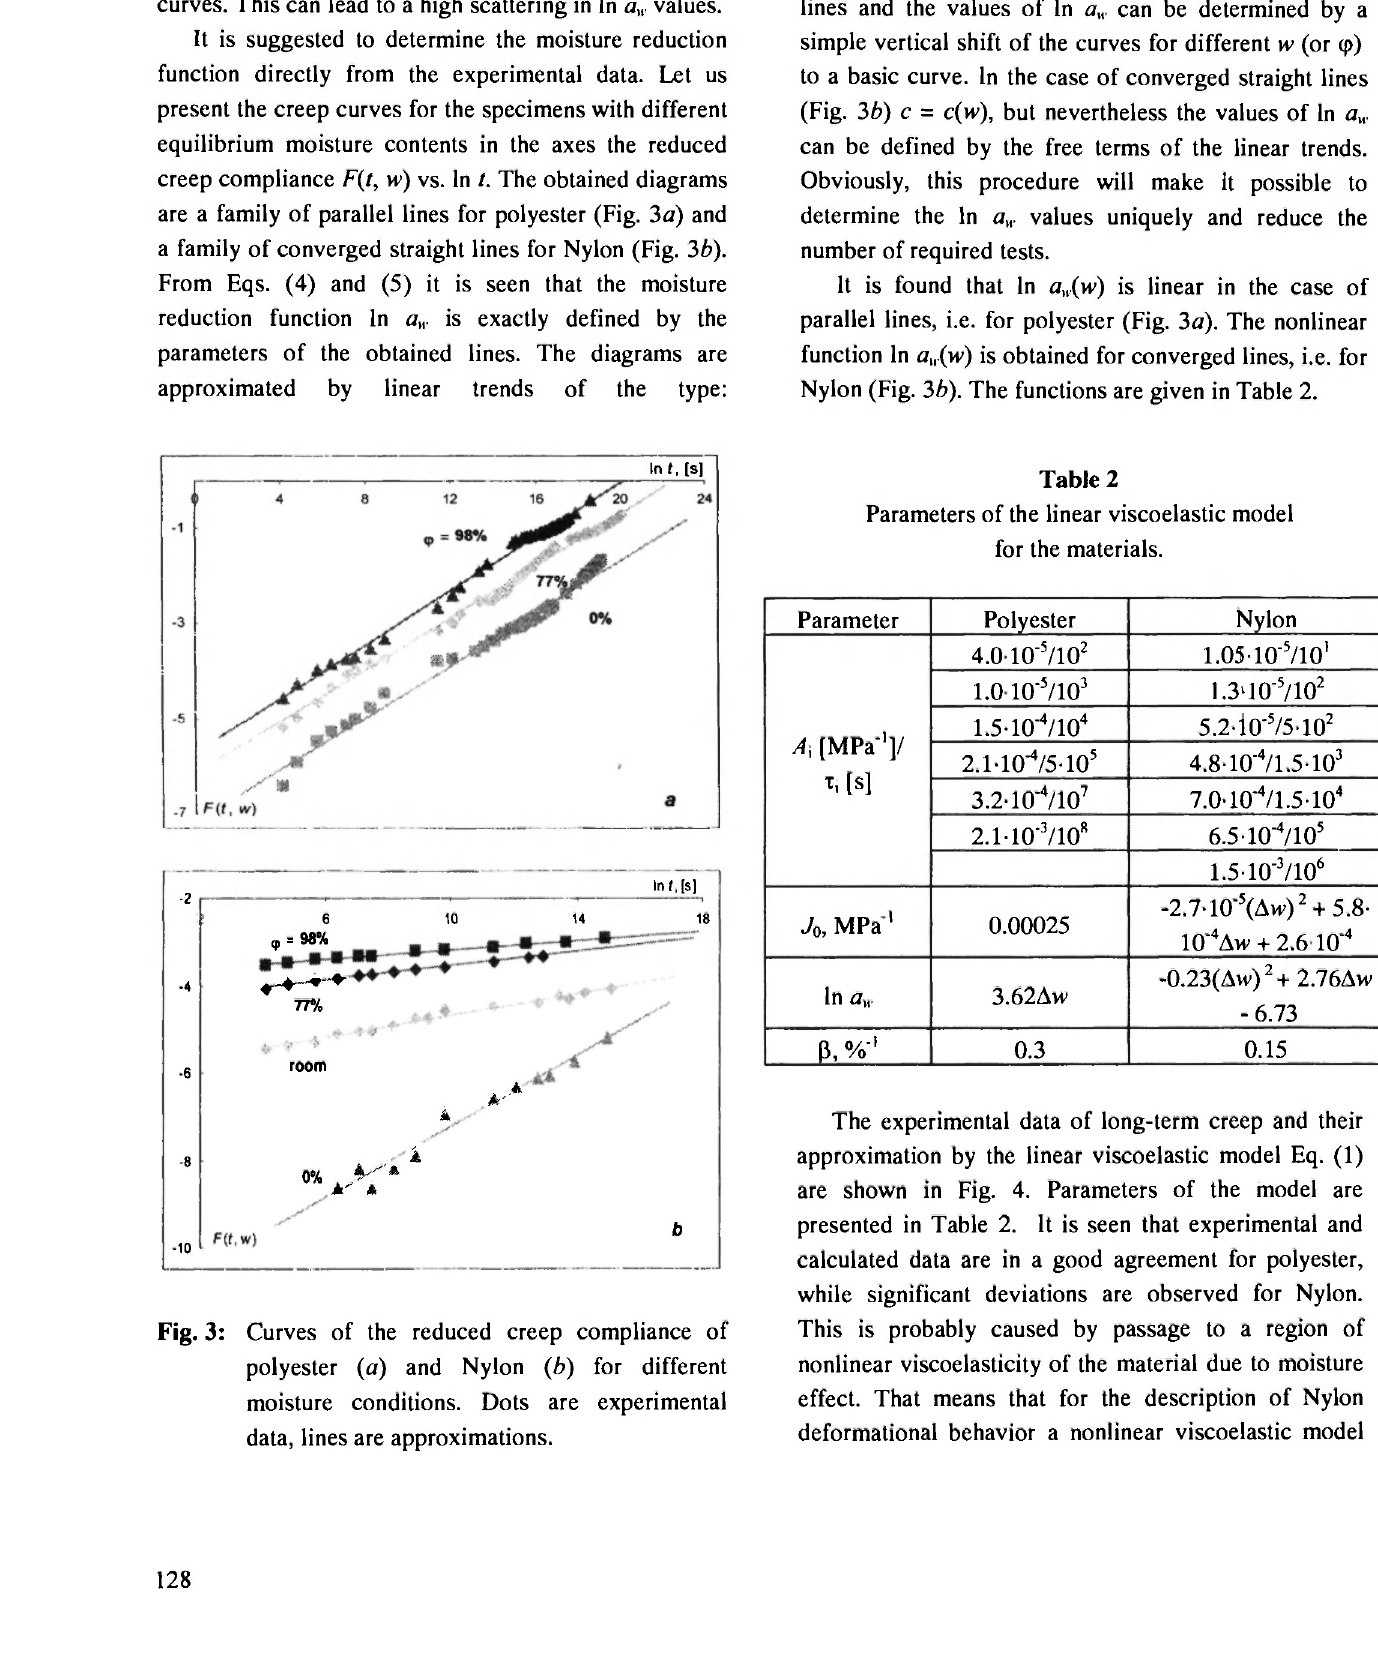
F(i,w) = clni + clna„.. The values of a coefficient c do not depend on moisture content in the case of parallel lines and the values of In a», can be determined by a simple vertical shift of the curves for different w (or φ) to a basic curve. In the case of converged straight lines (Fig. 3b) c = c(w), but nevertheless the values of In a„. can be defined by the free terms of the linear trends.